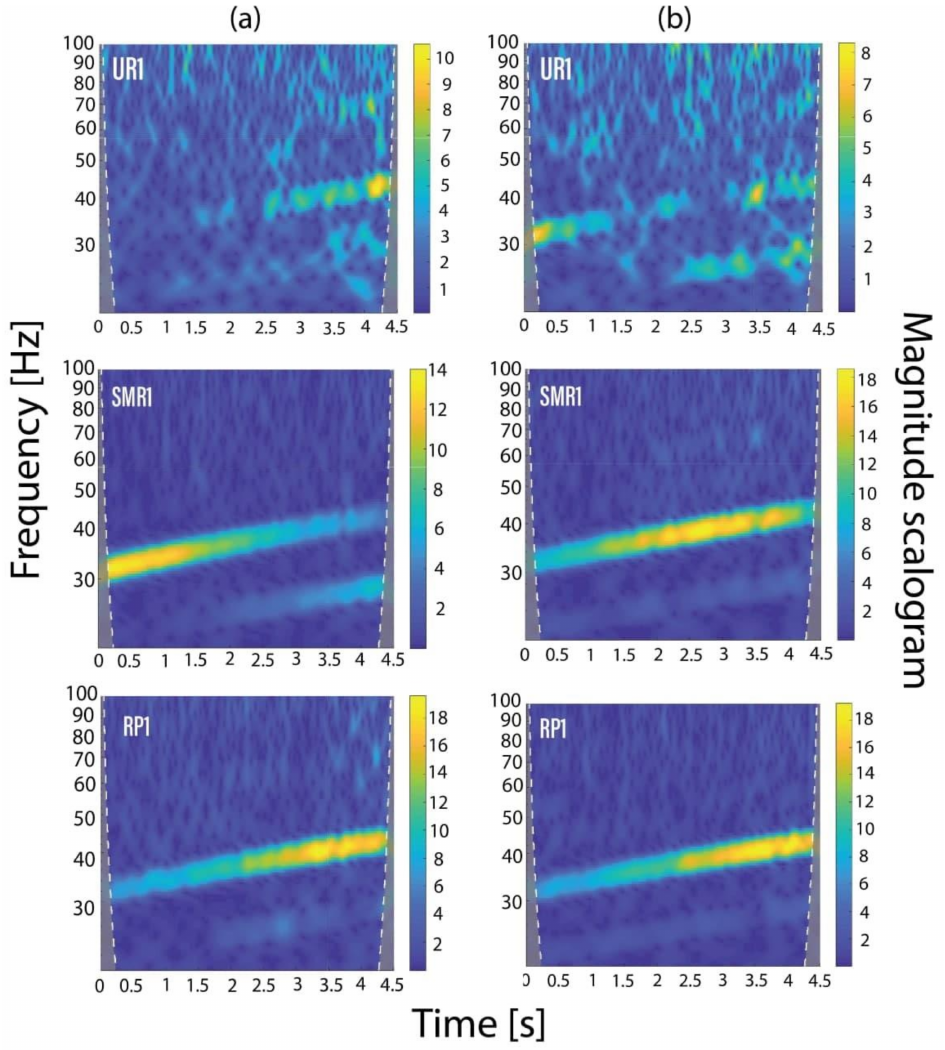
Figure 10. Scalograms wavelet analysis for group 1 between 10 and 100 Hz measured in UR1, SMR1, and RP1. ( a ) Analysis for P1. ( b ) Analysis for